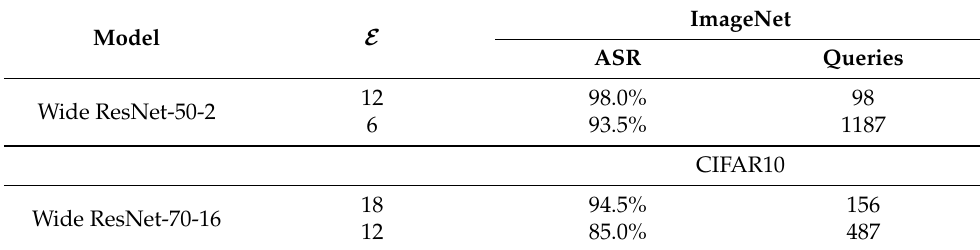
Table 4. QuEry Attack’s performance on robust models over CIFAR10 and